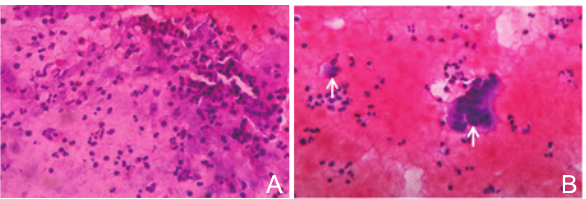
Figure 8 Cytological findings from the FNA specimen (× 40) (A) there is plenty of inflammatory cells with exudates; (B) Ciliated columnar epithelial cells (arrows) appear in the